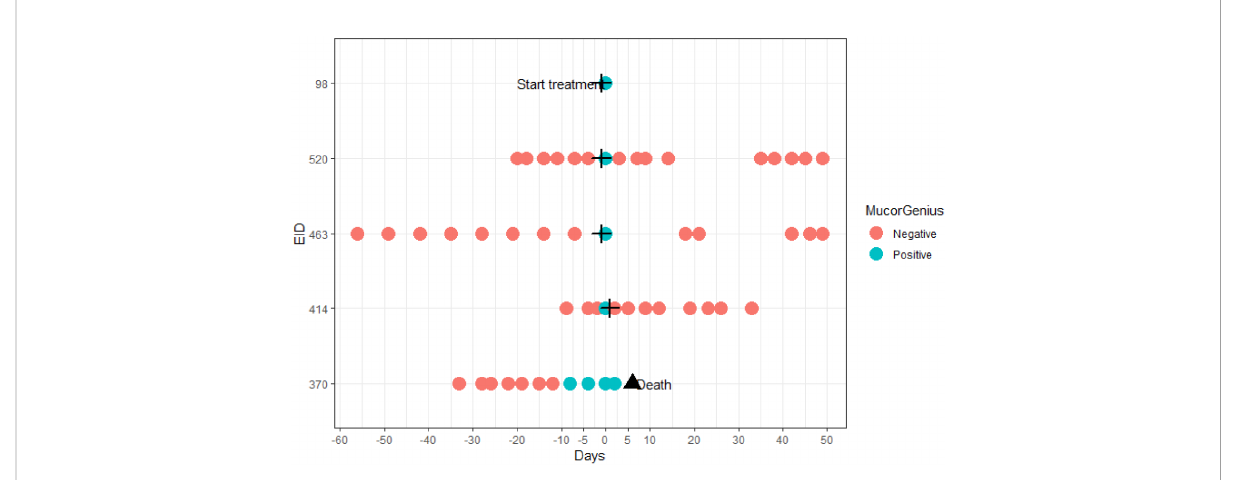
FIGURE 4 Temporal overview of the additional tested samples of patients with a positive Mucorales PCR in the diagnostic sample. The cross indicates start of anti-mold therapy; the triangle denotes death of a